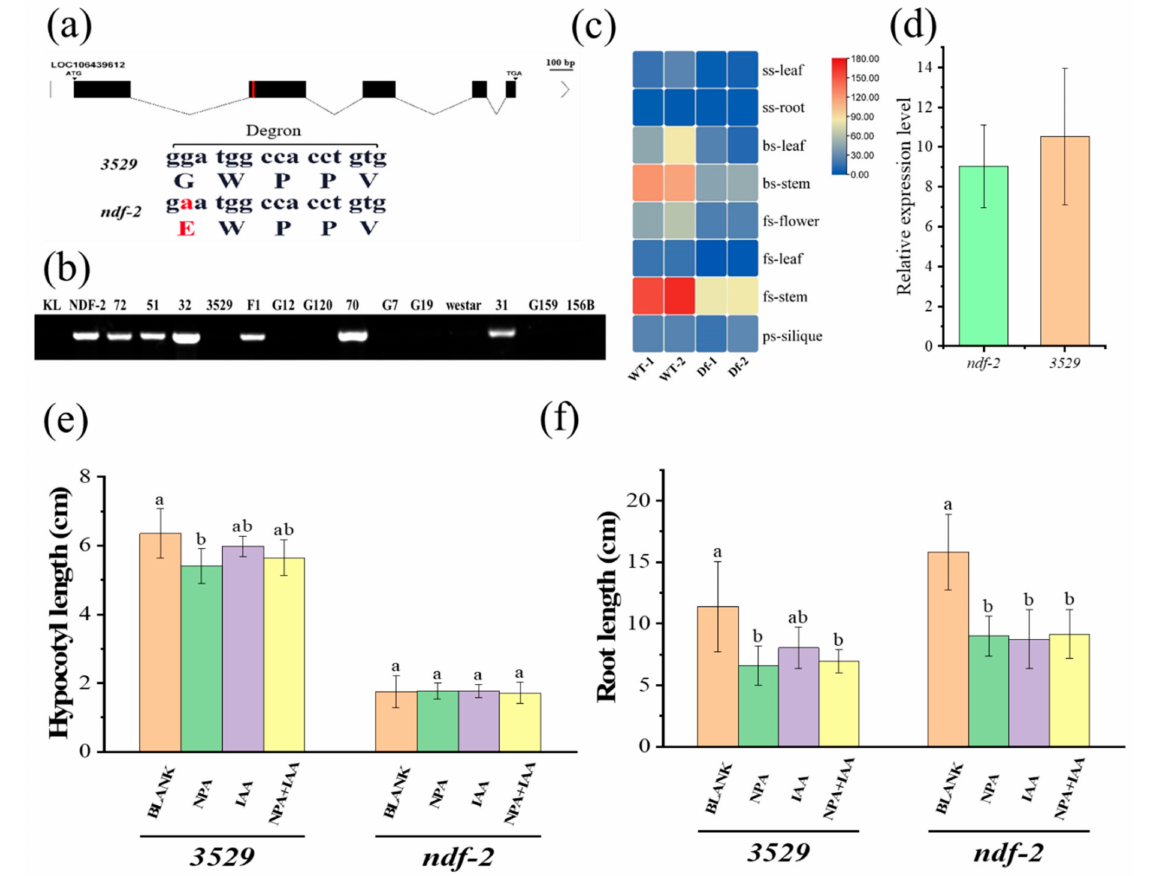
Figure 3. Structure and expression analysis of BnaA03.IAA7 gene and auxin response in 3529 and ndf-2 . ( a ) Structure of the NDF-2 gene ( LOC106439612 ). A SNP (G–A) in the second exon that converted the conserved Gly to Glu (G84E). Mutated nucleotides and amino acid residues are shown in red. ( b ) Validation of co-segregates between dwarfing phenotype and mutation site. Genotype of ndf-2 , 3529, F 1 , F 2 population (‘G + number’ and ‘number’ represent the tall and dwarf plants in the F 2 population, respectively) and two tall rapeseeds cultivar (westar and KL) were detected using the AS-PCR marker. ( c , d ) NDF-2 gene ( BnaA03.IAA7 ) expression levels were compared between ndf-2 (Df) and 3529 (WT), detected by RNA-seq ( c ) and qPCR ( d ). ( e , f ) 1-week-old seedlings of 3529 and ndf-2 were treated with auxin (IAA; 5 µ M), or NPA (0.5 µ M) or 5 µ M IAA with 0.01 µ M NPA for 20 days. Length of hypocotyl ( e ) and root of lateral roots ( f ) are shown, different lowercase letters denote significant differences among the conditions ( p < 0.05, one-way ANOVA followed by Tukey’s test for multiple comparisons). Values are the means ± SD ( n =